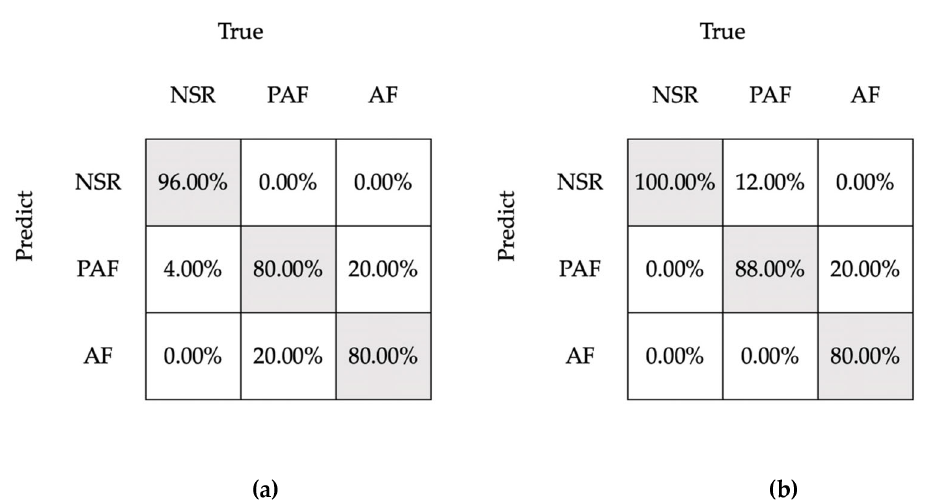
Figure 8. The confusion matrices show ( a ) ANN(100) and ( b ) ANFIS_trapmf models with the SAV variable.